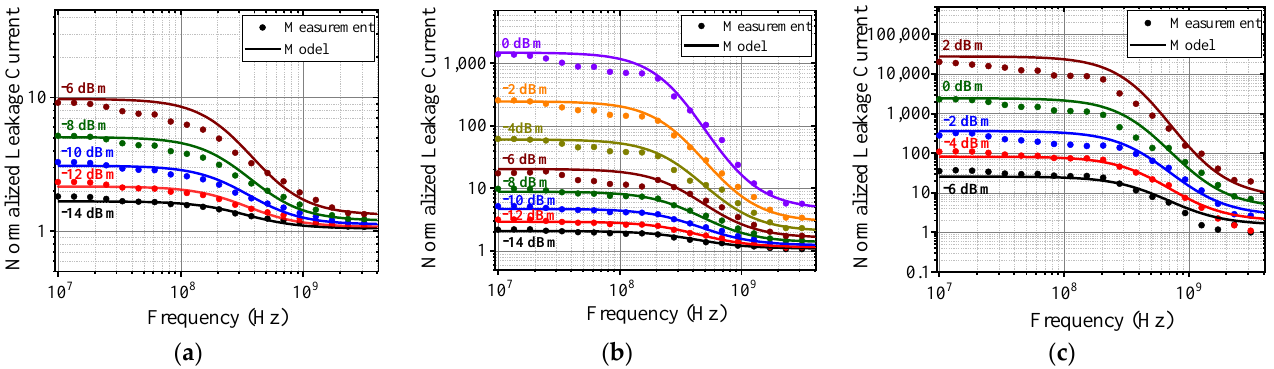
Figure 13. Comparison between the analytical model and the measured data for leakage current of PMOS for ( a ) 65 nm, ( b )